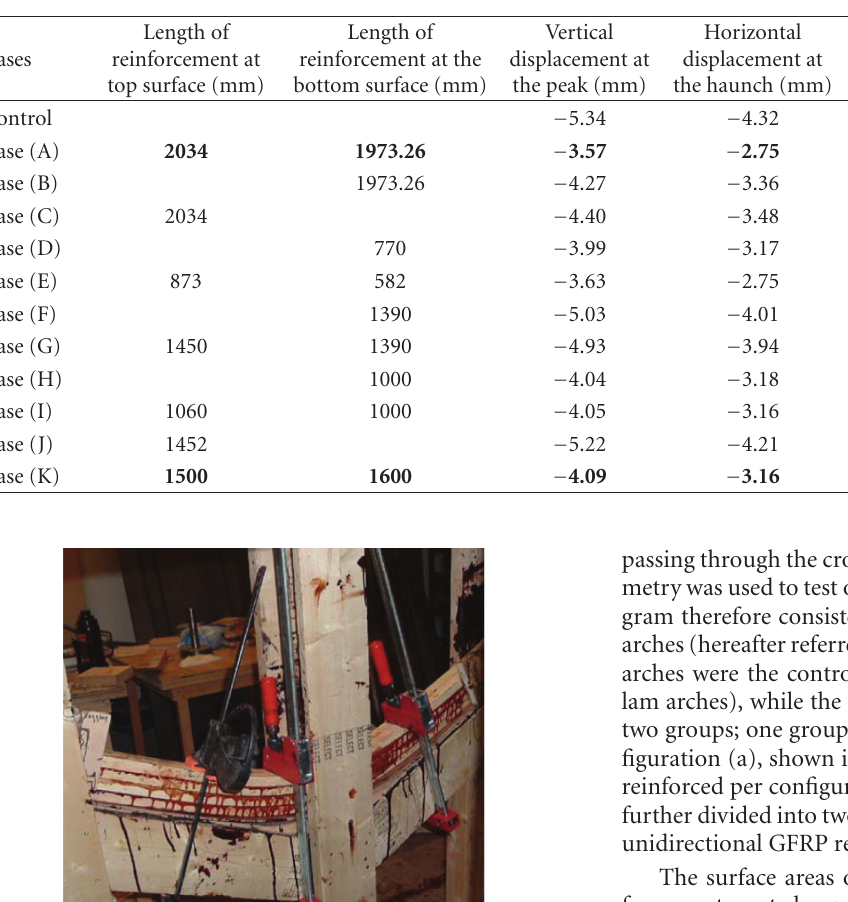
Table 2: Summary of the finite element results of the twelve models.